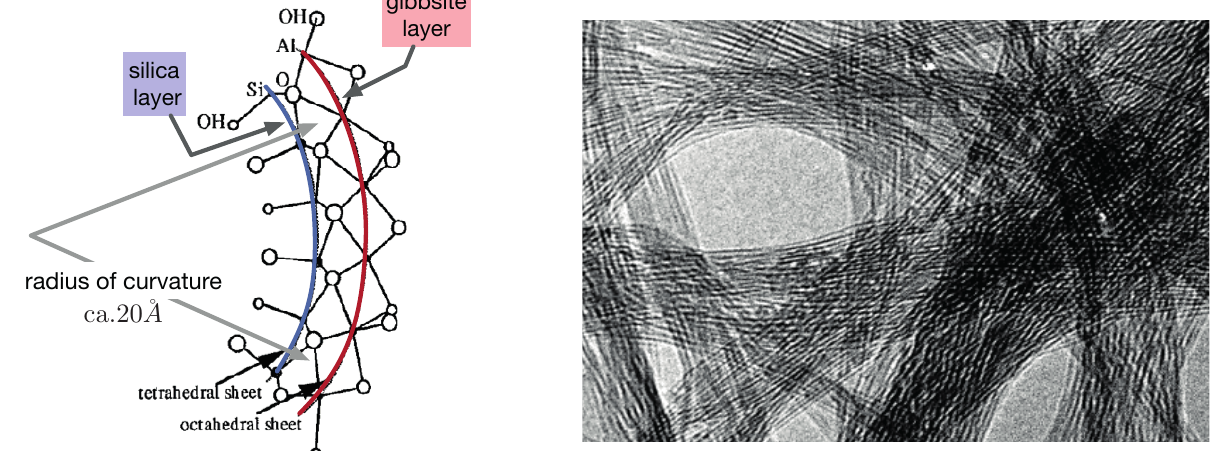
Figure 31. (Left ) Cross-section through a sector of cylindrical imogolite sheet (image adapted from CRADWICK et al., 1972) (Right) Elec- tron microscopic image of imogolite cylinders (scale bar 200 Å, image adapted from WADA, 1987).